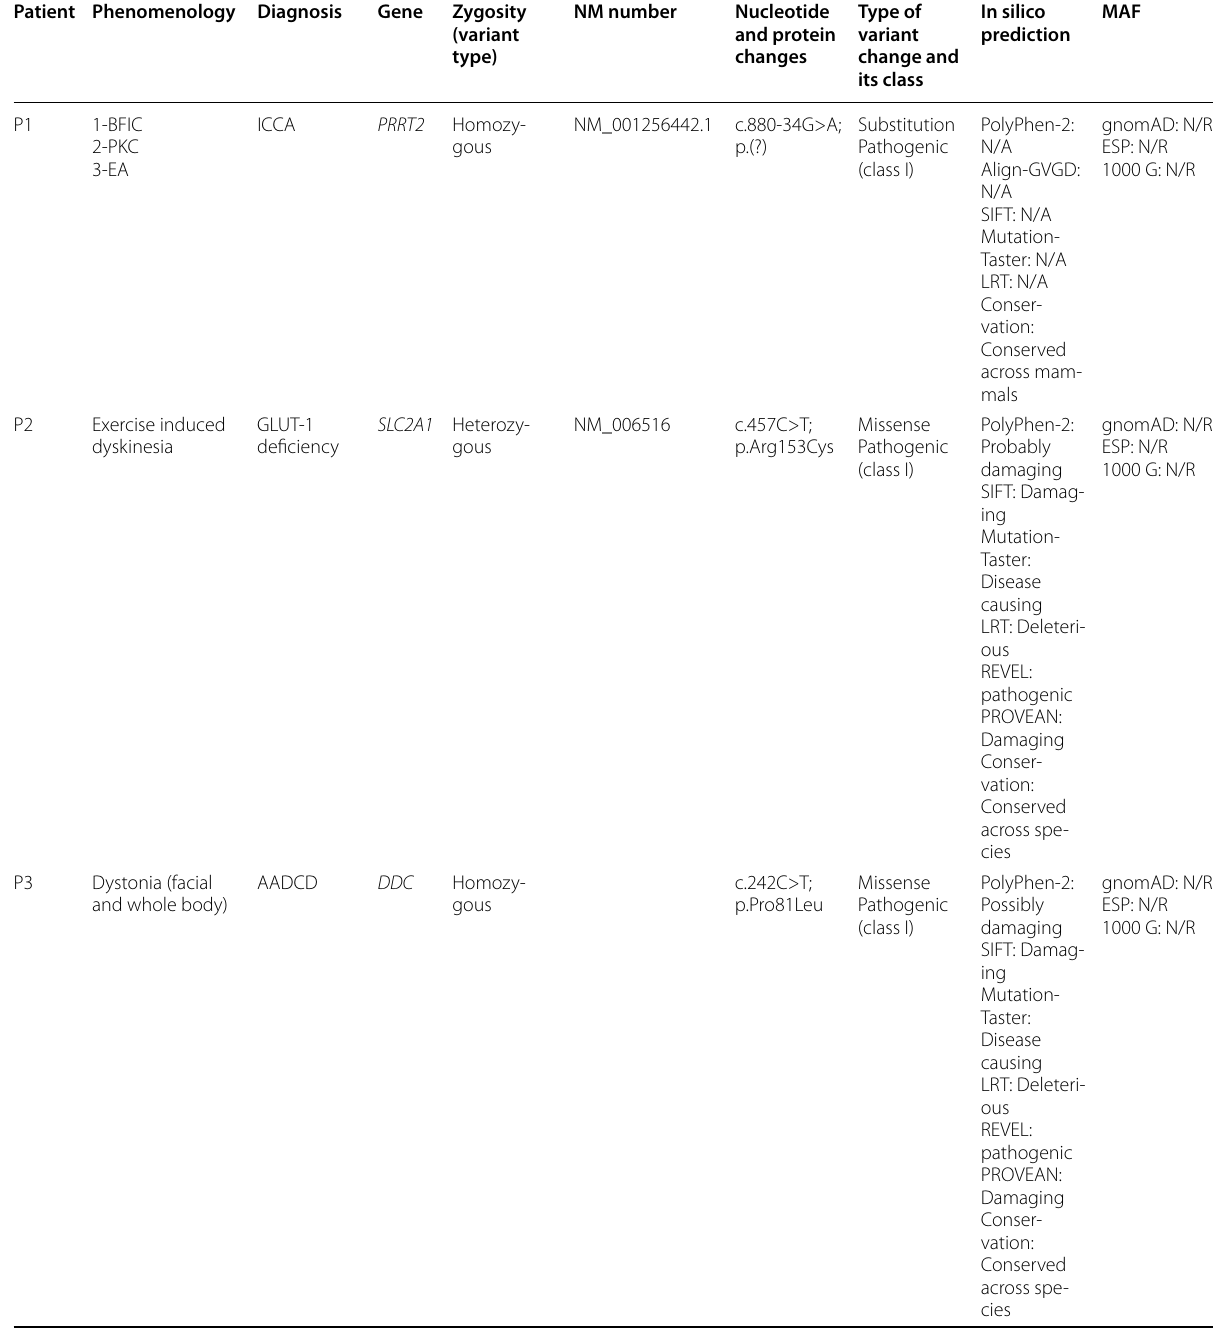
Table 4 Patient’s final diagnosis and phenotypic/genotypic correlation Patient Phenomenology